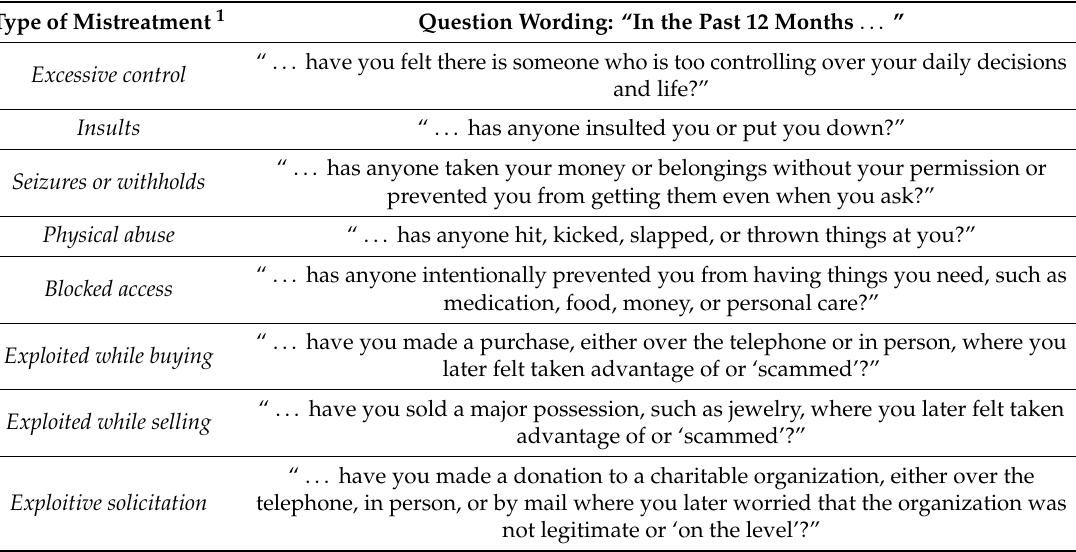
Table 2. Measurement of elder mistreatment